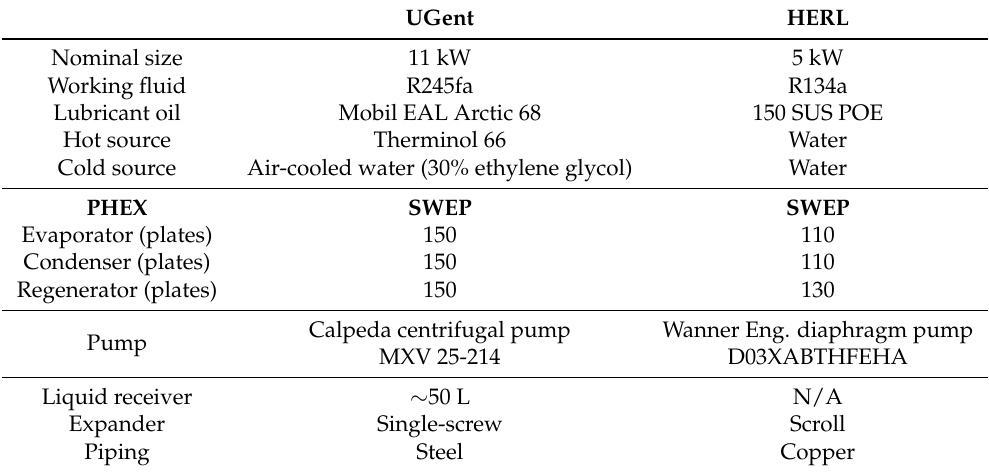
Table 3. ORC components for the experimental setup at UGent campus Kortrijk and at HERL, PU.